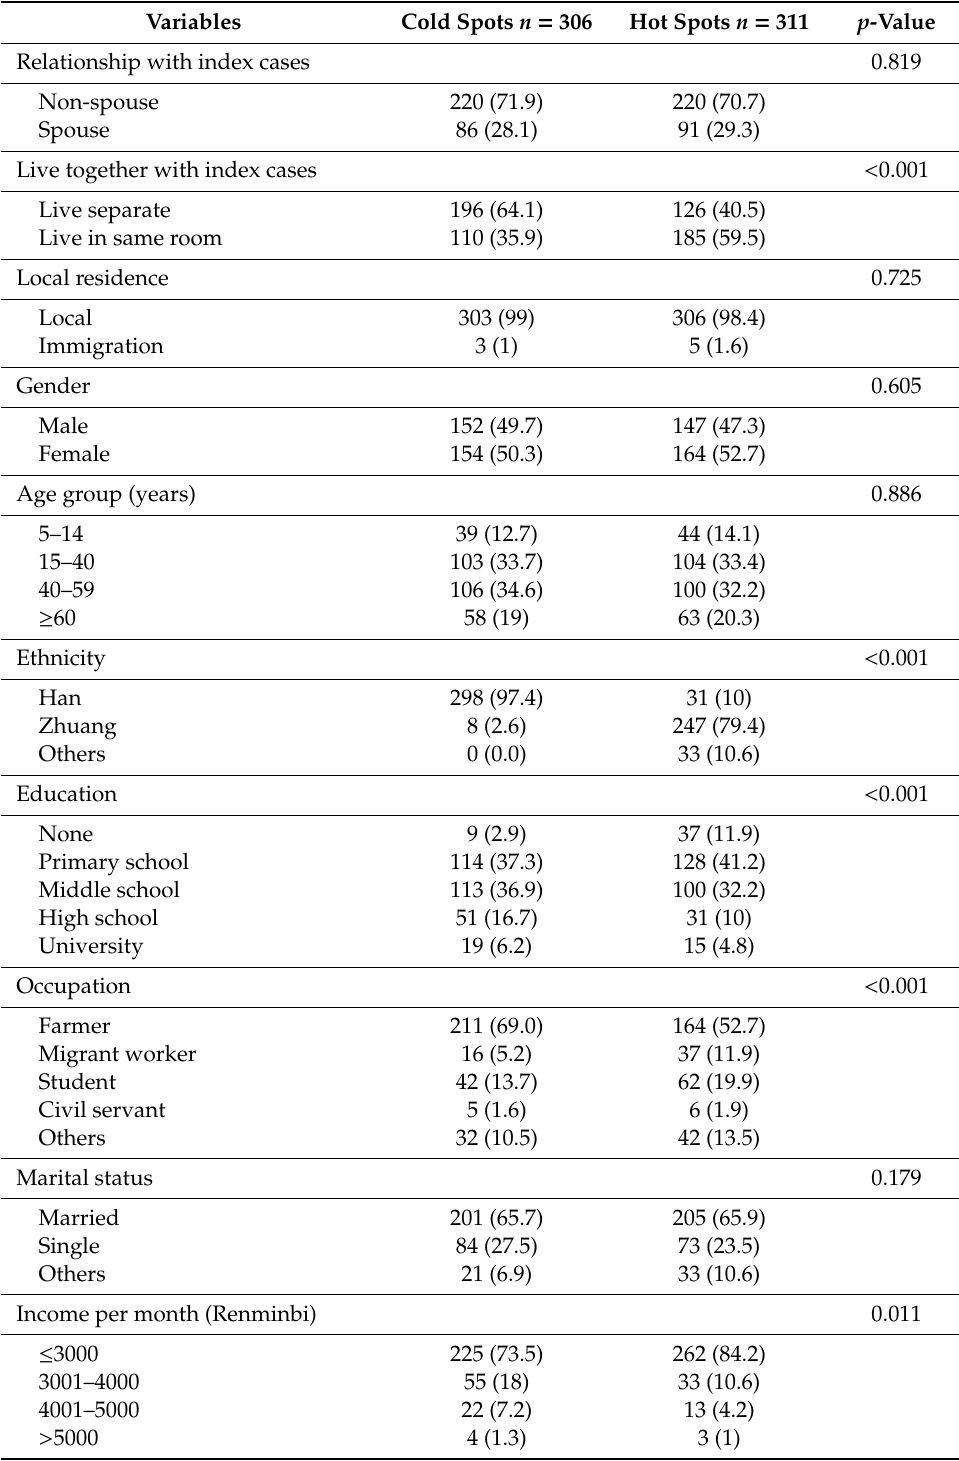
Table 2. Comparison of characteristics of the household contacts between cold and hot spot transmission